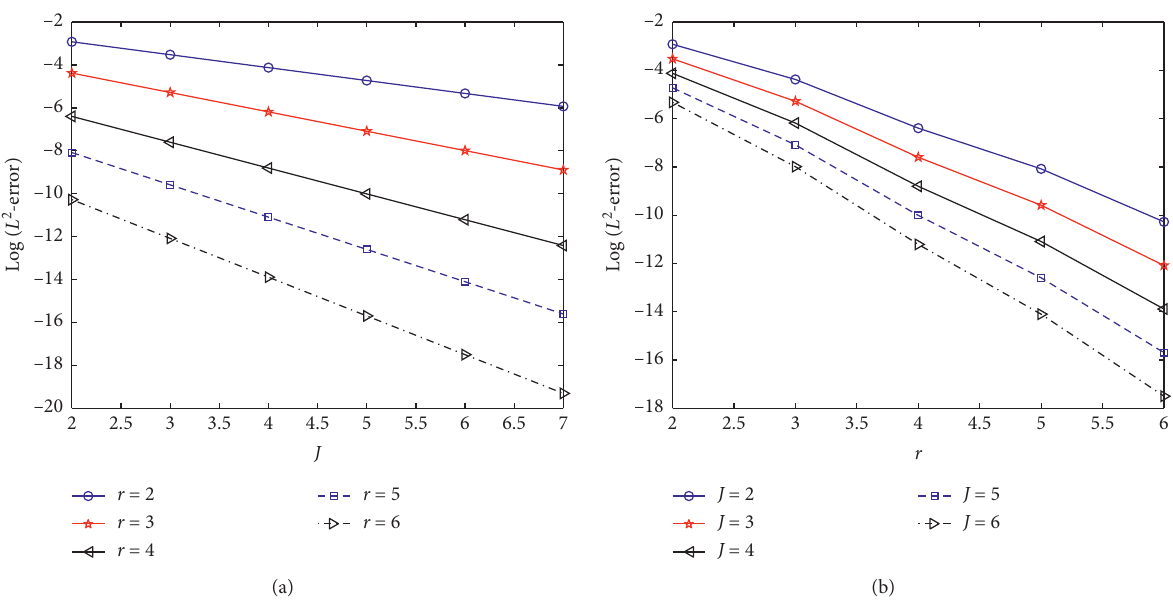
Figure 5: Effects of the refinement level J and multiplicity parameter r for Example 3.